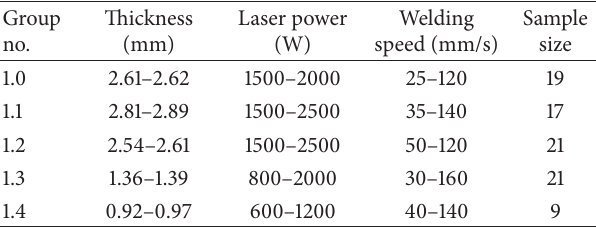
Table 1: Weld group and laser